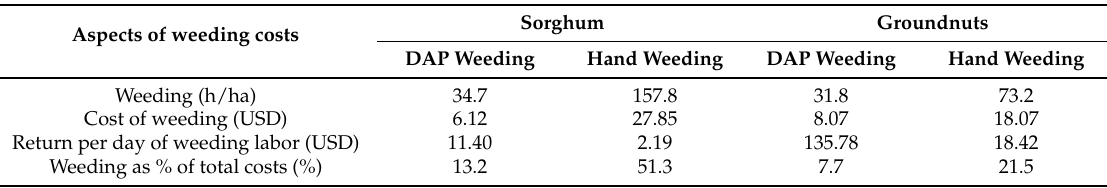
Table 1. Labor costs and returns with respect to weeding in NE